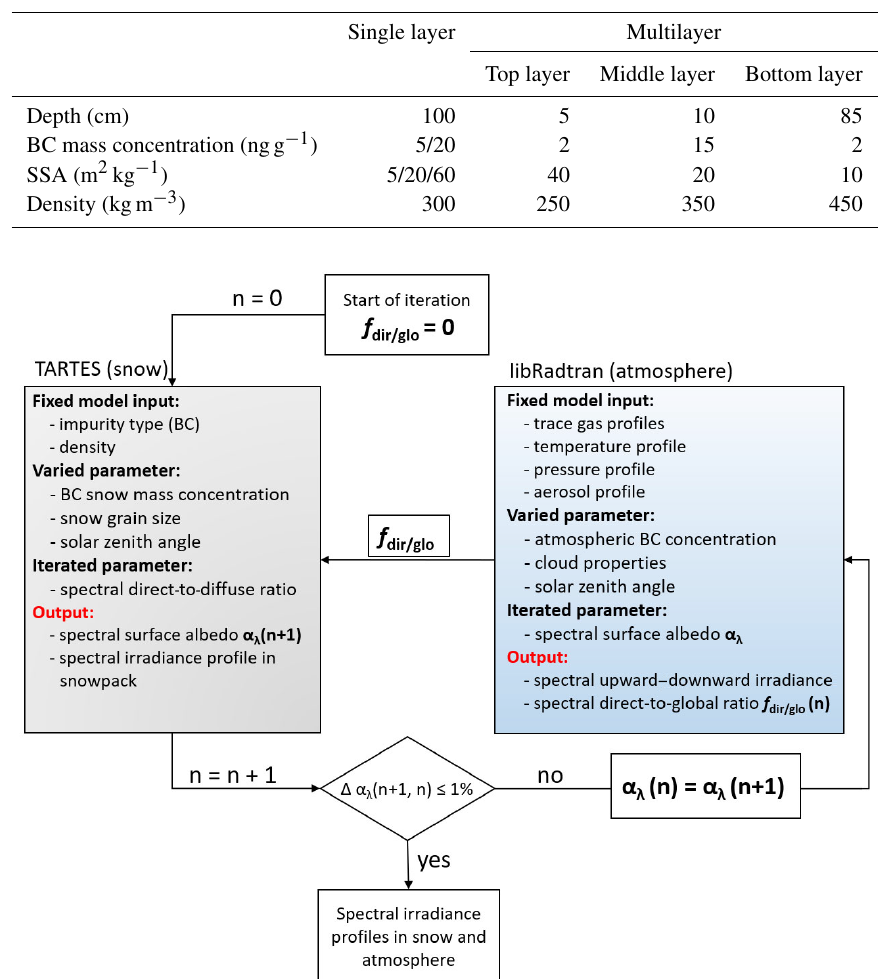
Table 3. Snowpack model setups for the single-layer and multilayer cases. The default SSA for the single-layer case is 20m 2 kg − 1 .